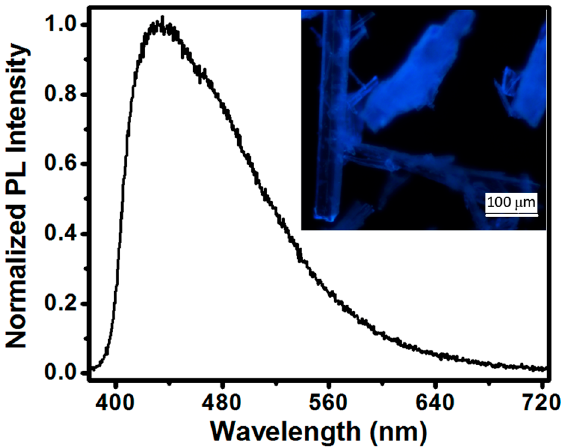
Figure 3. Normalized fluorescence emission spectrum of compound PPDPD in solid state (excitation wavelength 325–365 nm, exposure time 400 ms). PL: photoluminescence.